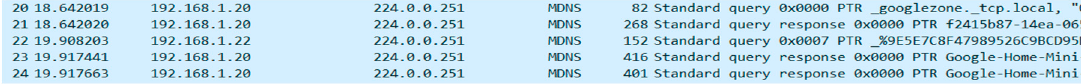
Figure 11. Packages that use the multicast domain name system (MDNS)